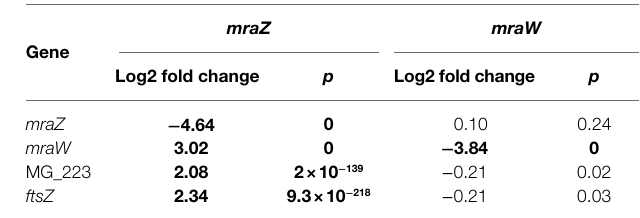
TABLE 1 | Transcriptional changes in the mraZ and mraW mutants by